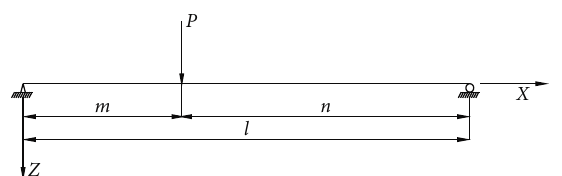
Figure 5: Schematic representation of a simply supported composite box girder with CSWSB under concentrated load